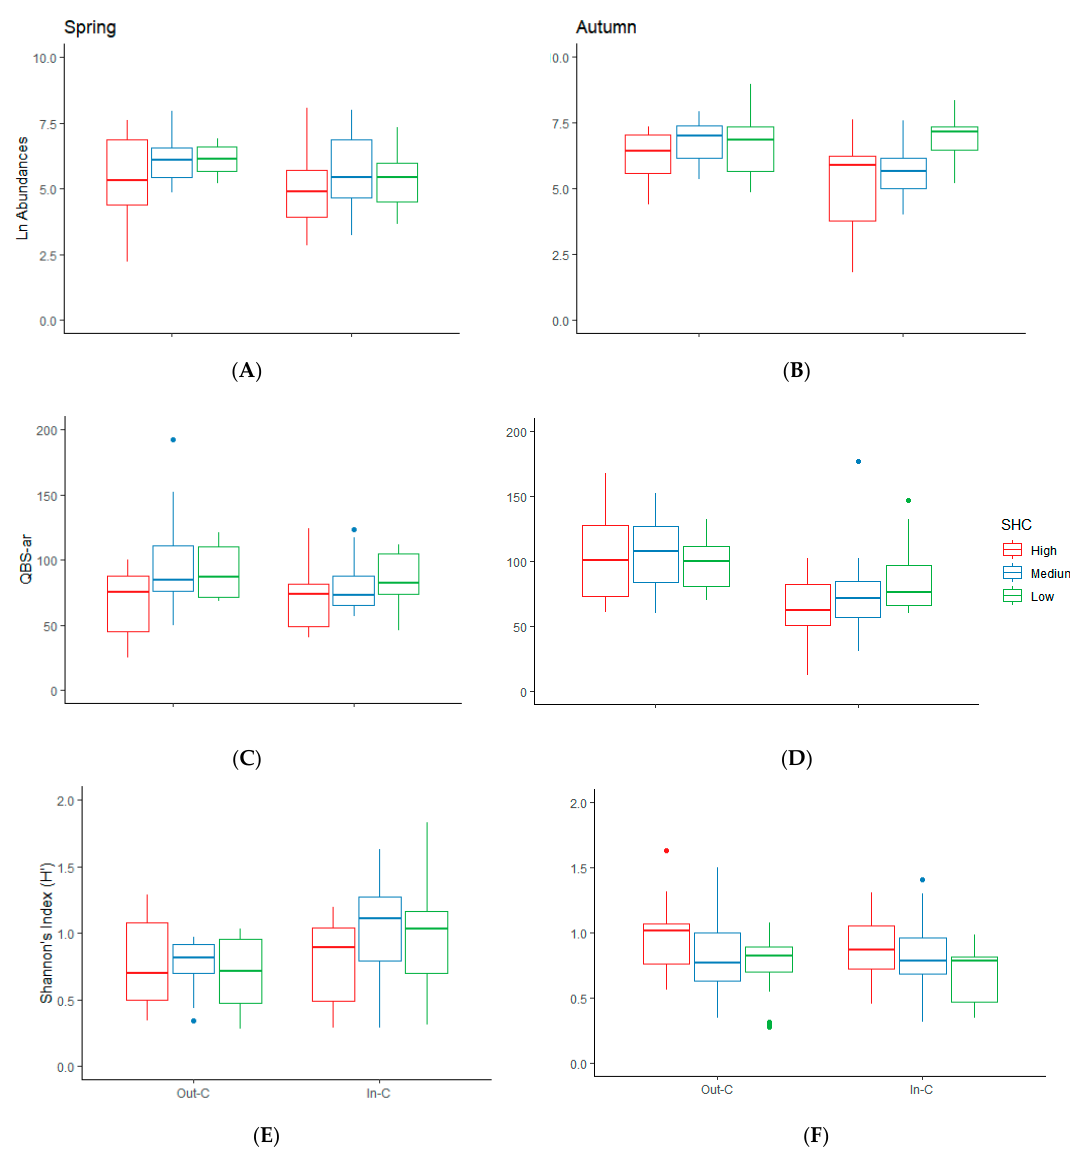
Figure 3. Boxplots showing the distribution of data for each response variable by soil habitat condition (SHC) and location factor (outside the canopy = Out-C or beneath tree canopy = In-C) in both seasons. ( A ) and ( B ) plots show log-transformed abundances; ( C ) and ( D ) plots show QBS-ar values; ( E ) and ( F ) plots show H ′ index values.